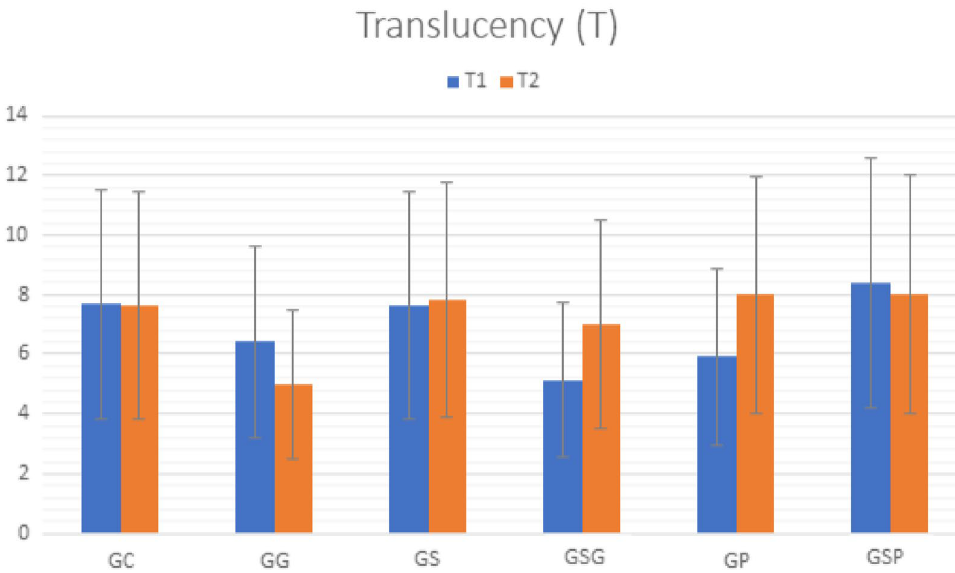
Figure 5. Translucency (T) presented as mean values and standard deviation of 5Y-PSZ groups at T1 and